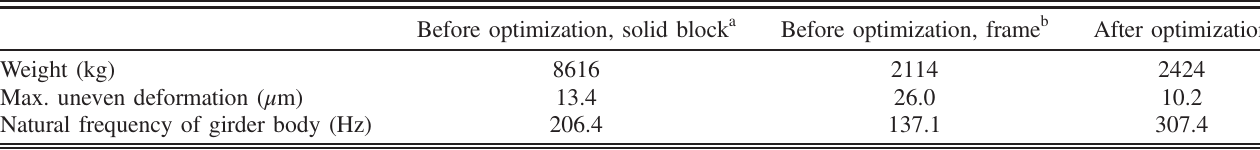
TABLE III. Improvements of the girder body before and after topological